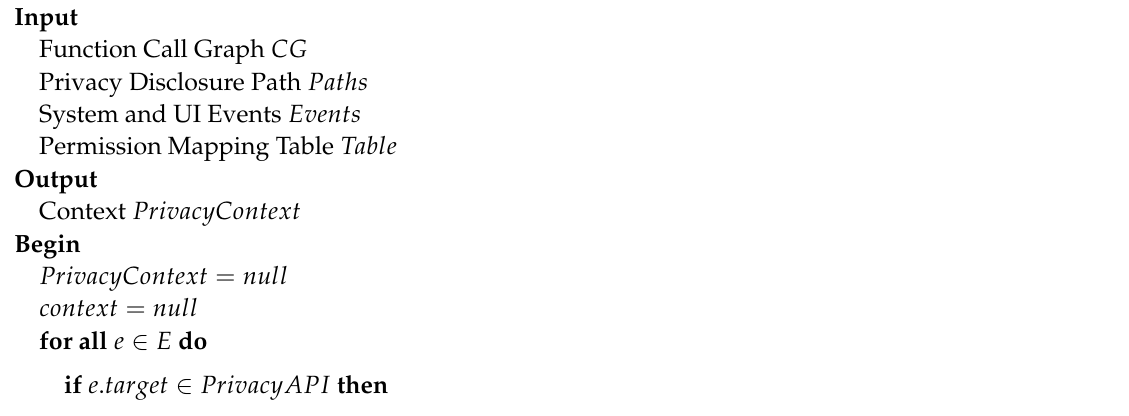
Algorithm 1 Context construction